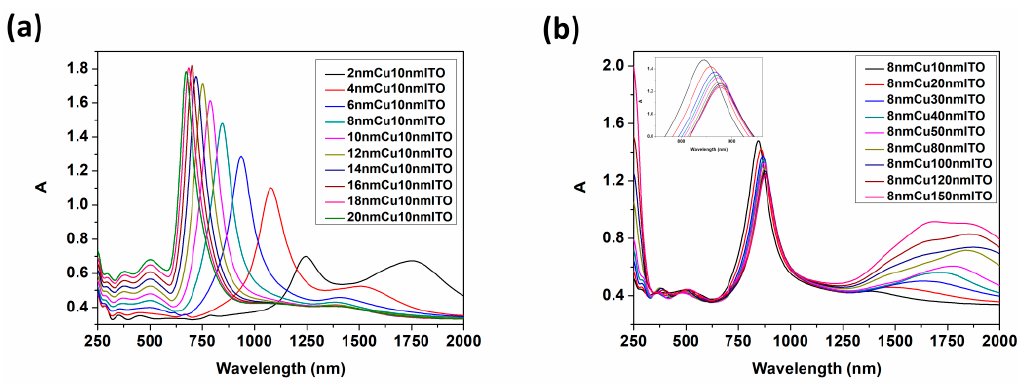
Figure 4. Regulation of the absorption under di ff erent layer thicknesses: ( a ) shows the case of di ff erent Cu thicknesses; ( b ) shows the case of di ff erent ITO thicknesses.